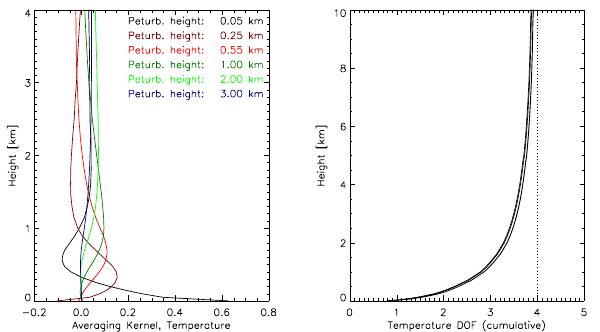
Fig. 7. Temperature averaging kernels ( δT retrieved ,i / δT true ,j ) for the mean temperature profile from the complete Payerne data set (1992–2009) as a function of height shown for different heights of perturbation (left). Cumulative Degrees of Freedom (DOF) for temperature with height (right). The DOF at each height corresponds to the diagonal value of the averaging kernel. The four different curves correspond to different seasons (summer/winter) and different radiosonde ascent times (00:00/12:00UTC) derived from complete Payerne data set (1992–2009).